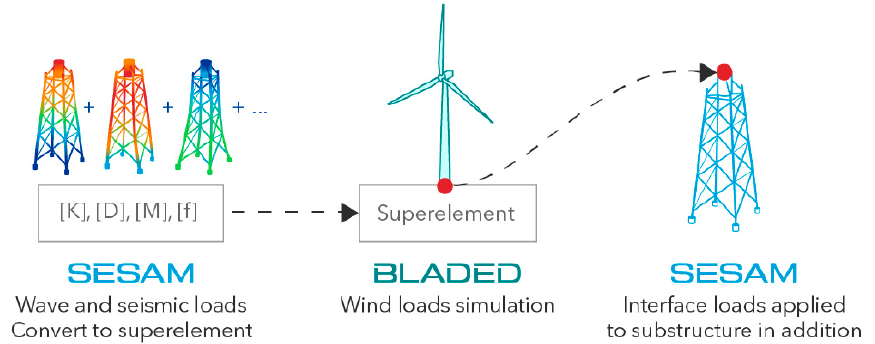
Figure 6. Super-element method [39].